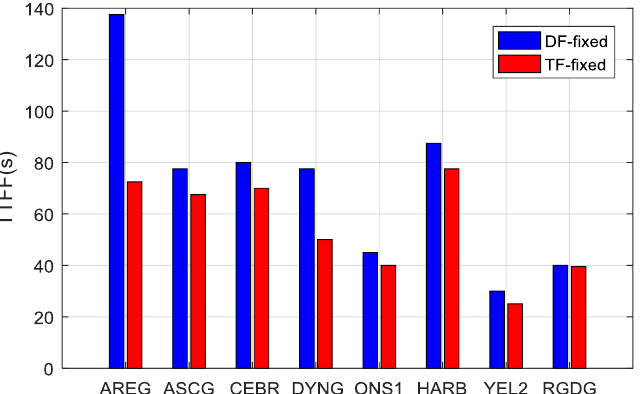
Figure 12. TTFF of LEO-only PPP AR for each user station.